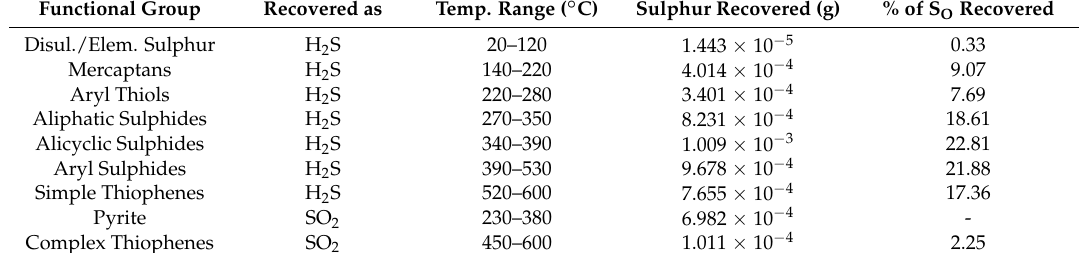
Table 11. Results for the TPI of mequinenza lignite.